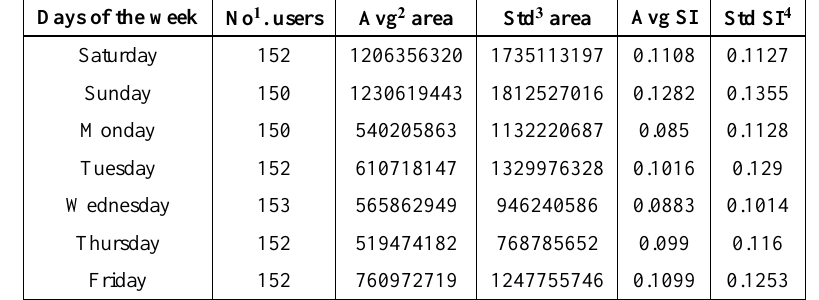
Table 1. Average and standard deviation of area and shape index of users' activity space grouped by days of the